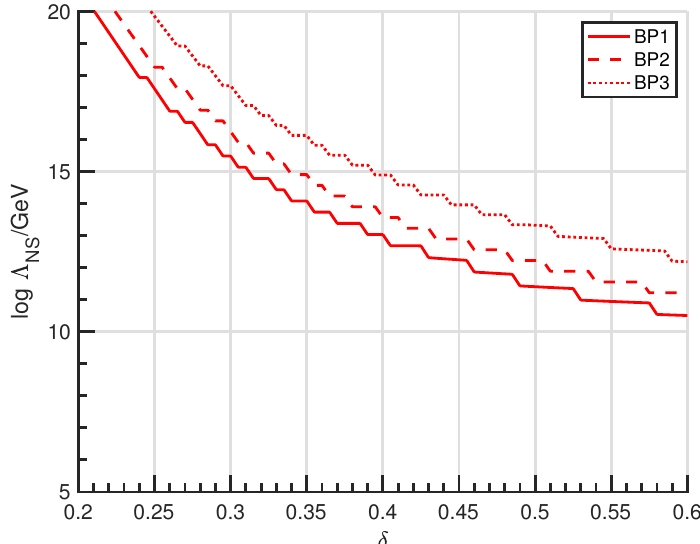
Figure 7. The rise of the instability scale ( above ) and the fall of the non-perturbative scale ( below ) as a function of threshold correction δ , for BP1 – BP3 .